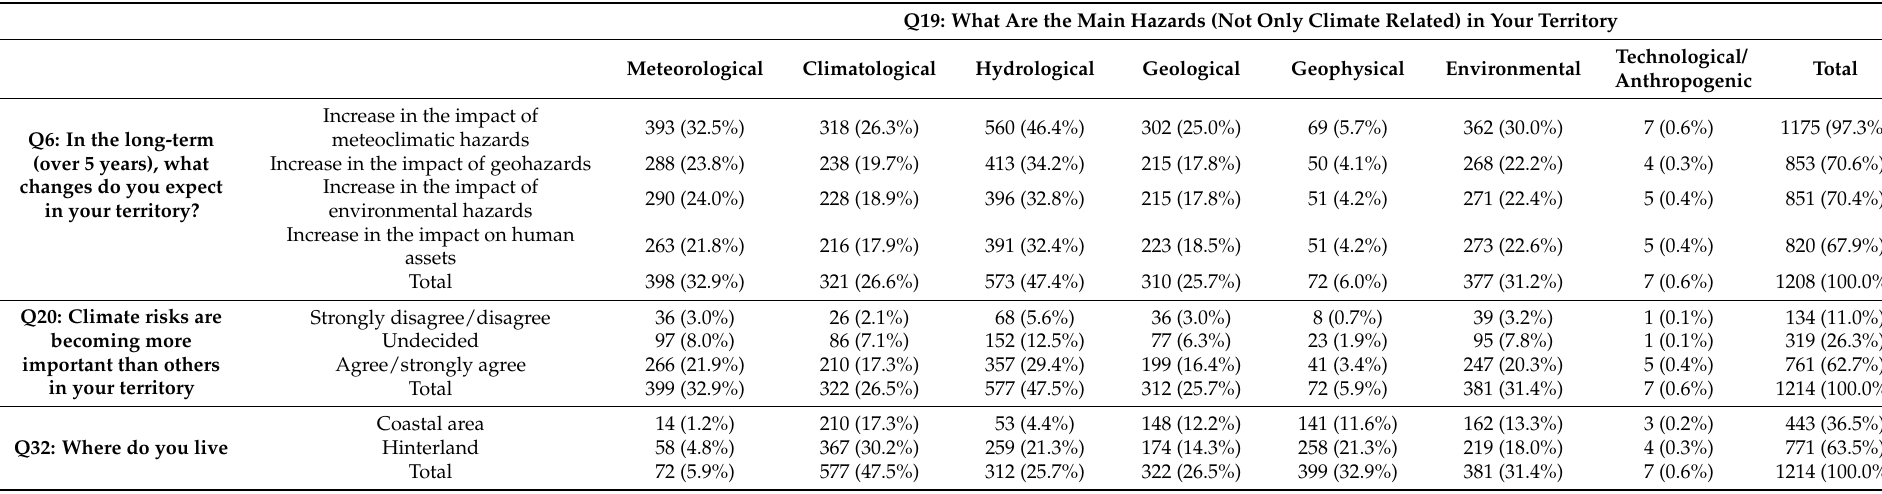
Table A8. Cross table of Q6 and Q19, Q20 and Q19, and Q32 and Q19, with frequencies (percentages) of the answers. Q19: What Are the Main Hazards (Not Only Climate Related) in Your Territory Technological/ Meteorological Climatological Hydrological Geological Geophysical Environmental